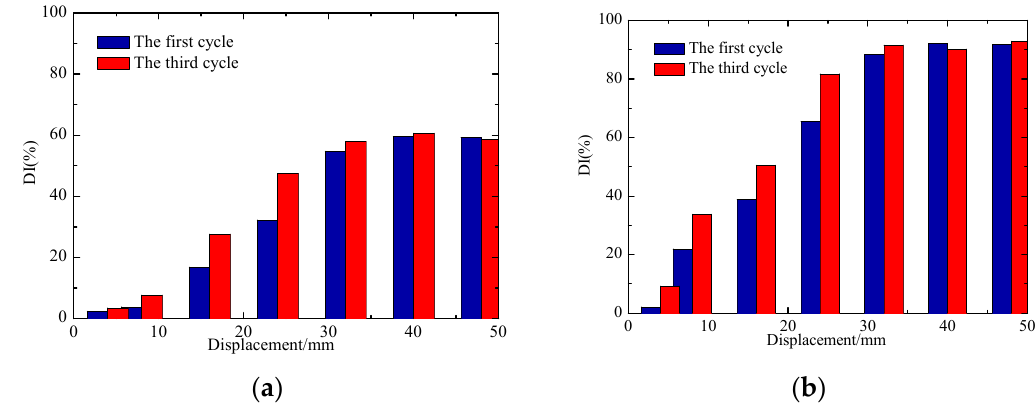
Figure 18. The damage indices of JD-2 in different cycles. ( a ) S1-S2; ( b ) S1-S3.